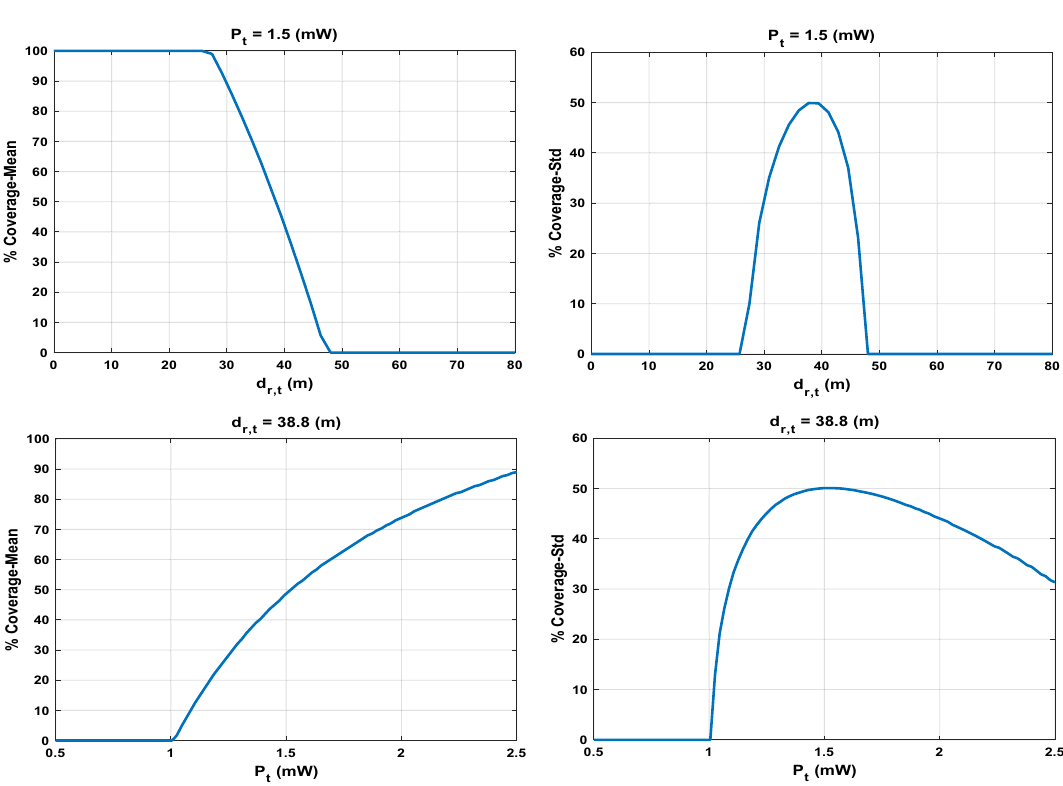
Figure 5. The mean and Std of coverage over each input parameter in an inner array of crossed design. In each figure, the second parameter fixed in certain value, P t = 1.5 ( mW ) and d r , t = 38.8 ( m )